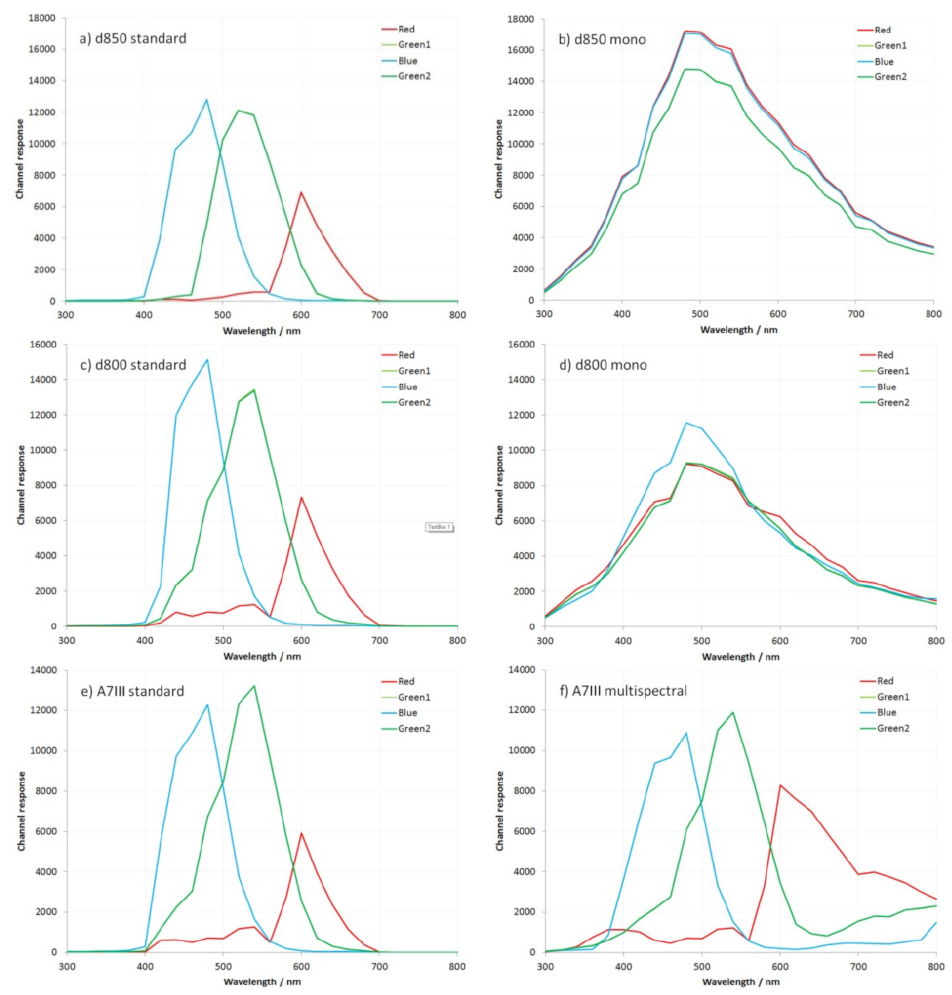
Figure 1. Measured sensor response curves between 300 and 800 nm for ( a ) standard Nikon d850, ( b ) monochrome-converted Nikon d850, ( c ) standard Nikon d800, ( d ) monochrome-converted Nikon d800, ( e ) standard Sony A7III, and ( f ) multispectral converted Sony